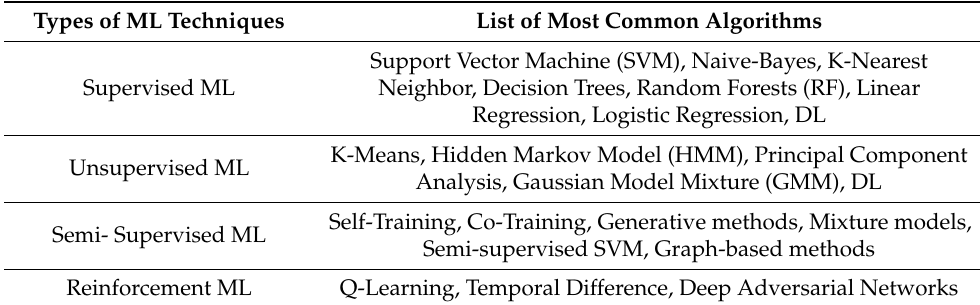
Table 1. Type of ML techniques and the algorithms associated with each technique. Types of ML